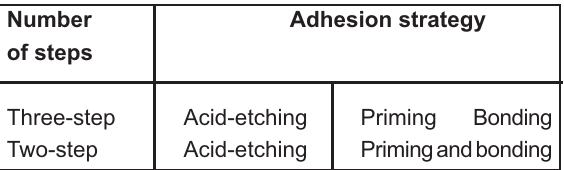
Figure 1- Etch-and-rinse adhesive systems -